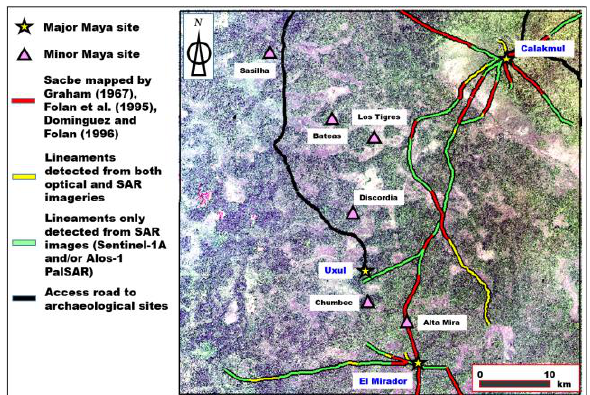
Figure 14. Network of lineaments corresponding probably to sacbeob mapped in the study area, from the photointerpretation of Landsat-5 TM, Landsat-7 ETM+, Landsat-8 OLI, Sentinel-1a, and Alos-1 PalSAR imageries, together with the sacbe segments of Graham (1967) and Folan et al. (1995), the access roads to the Uxul and Calakmul archaeological sites, as well as some Maya sites of the study